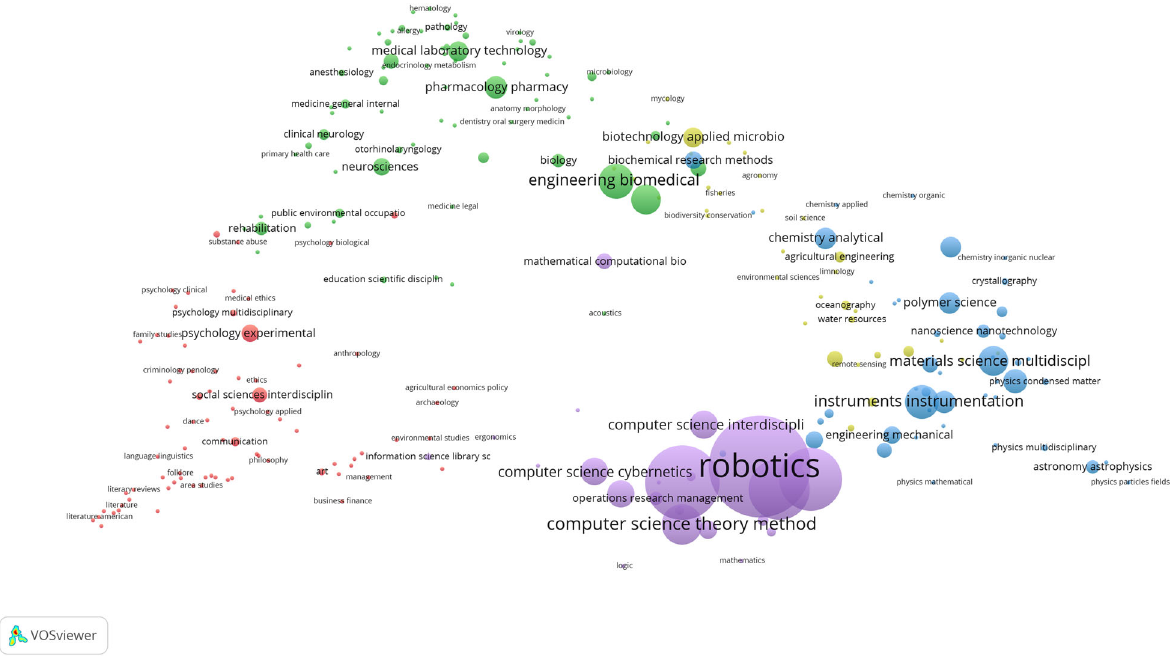
Fig. 4 Bibliometric research pro fi le of BRL using a science overlay map technique (Carley et al., 2017) illustrating key disciplines represented in BRL publications indexed in Web of Science. The overlay map illustrates the following “ disciplinary ” clusters: machine software (purple), machine hardware (blue), environment (yellow), medicine (green), human factors and society (red) (based on 485 publications; 2004 – 2020).